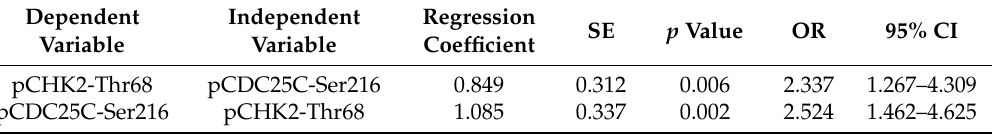
Table 4. Multivariate logistic regression analysis.